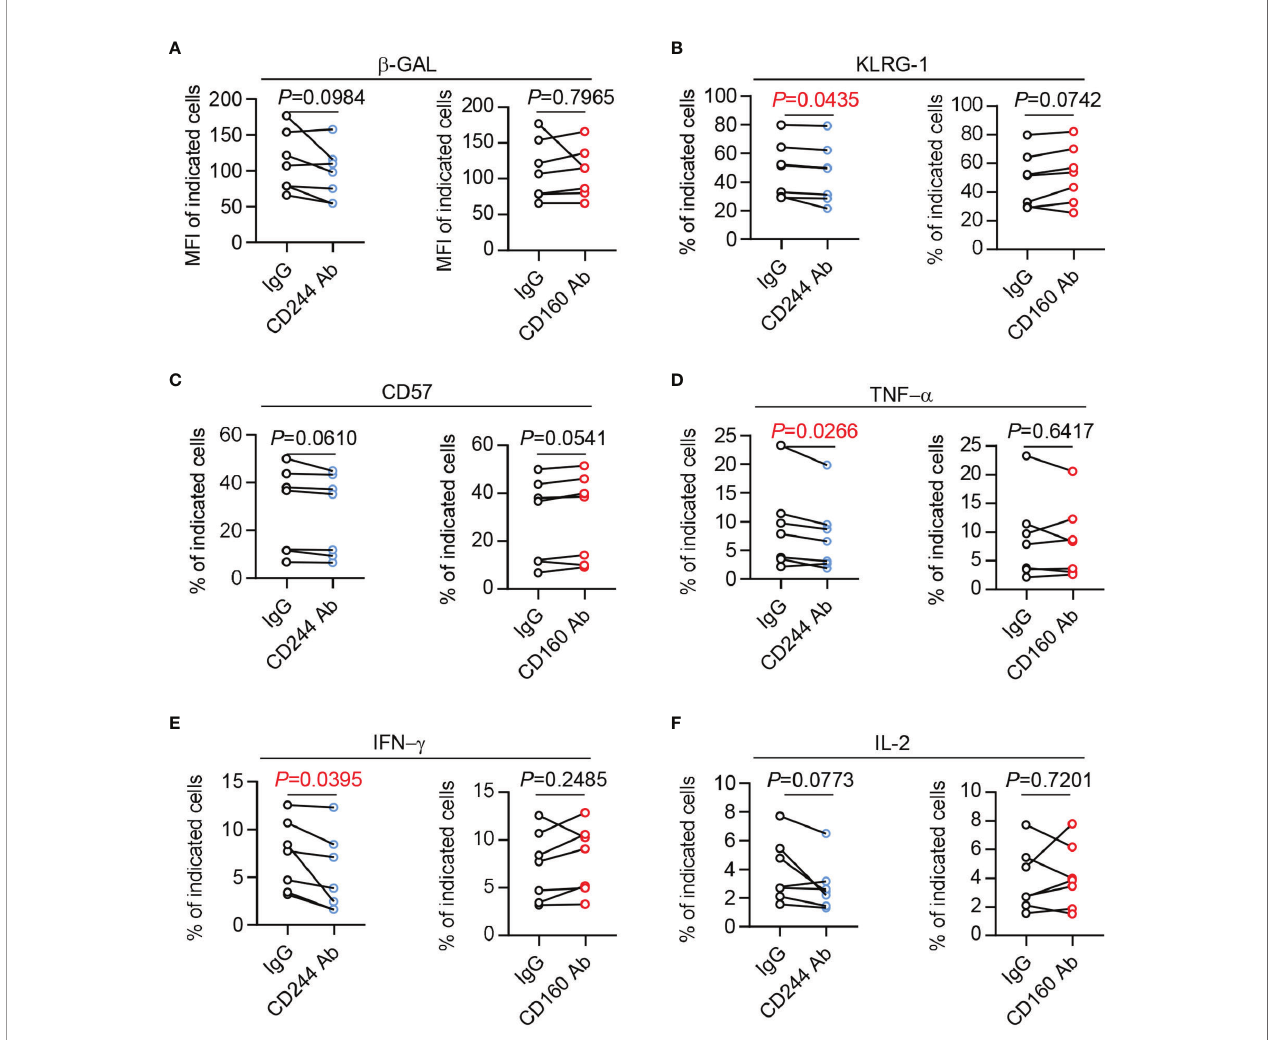
FIGURE 7 | The senescent status and cytokine production of CD8 + T cells could be reversed by CD244 but not CD160 blockade. Puri fi ed CD8 + T cells from healthy donors (n = 7) were cultured with antagonist anti-CD244, anti-CD160 antibody, or isotype IgG at a concentration of 10 µg/mL. After culturing in vitro for 24h, the activity of b -Gal (A) , KLRG-1 (B) , CD57 (C) , TNF- a (D) , IFN- g (E) , and IL-2 (F) expression on CD8 + T cells was measured by fl ow cytometry. Representative plots of the above markers in CD8 + T cells. P values were obtained by